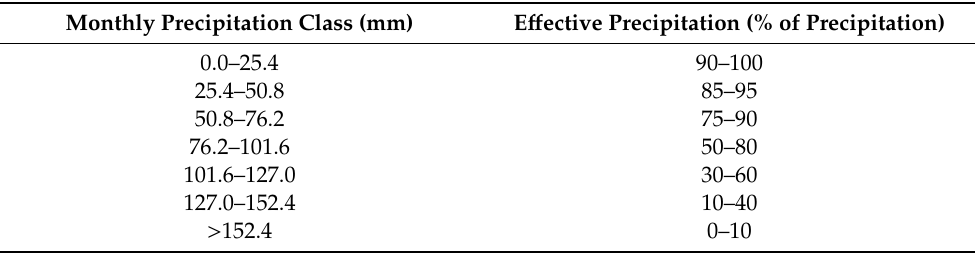
Table 2. Monthly precipitation classes and corresponding percentage for estimating e ff ective precipitation based on US Bureau of Reclamation